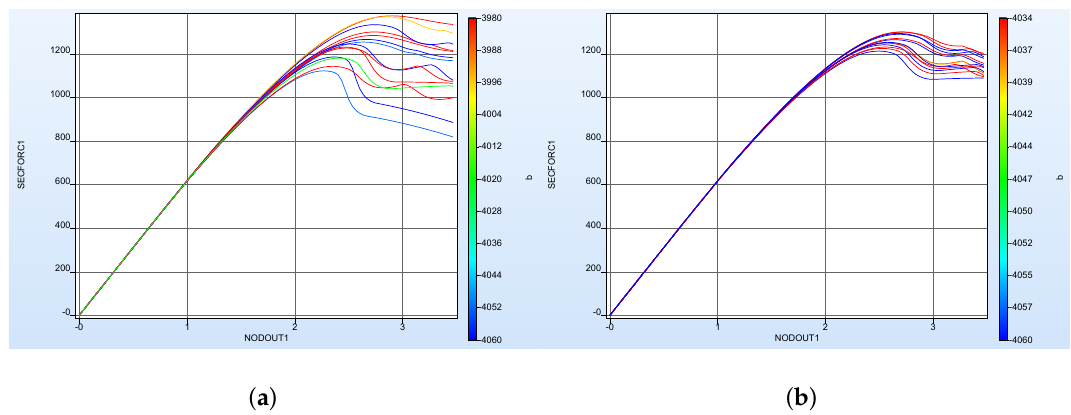
Figure 6. FDC from the parameter identification process with LS-OPT at ( a ) iteration 1 and ( b ) iteration 4 ( SECFORC1 — LS-DYNA output for the force and NODOUT1 —for